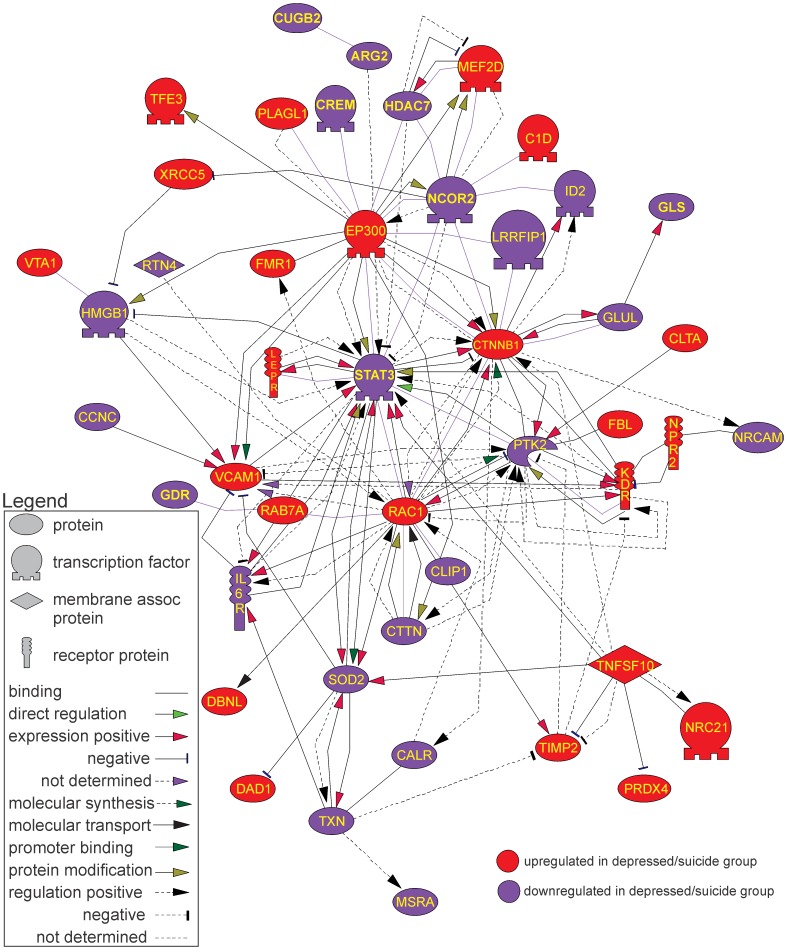
Gene relationship network generated for differentially expressed genes based on known direct relationships.For detailed description of various types of relationships see Table S1.